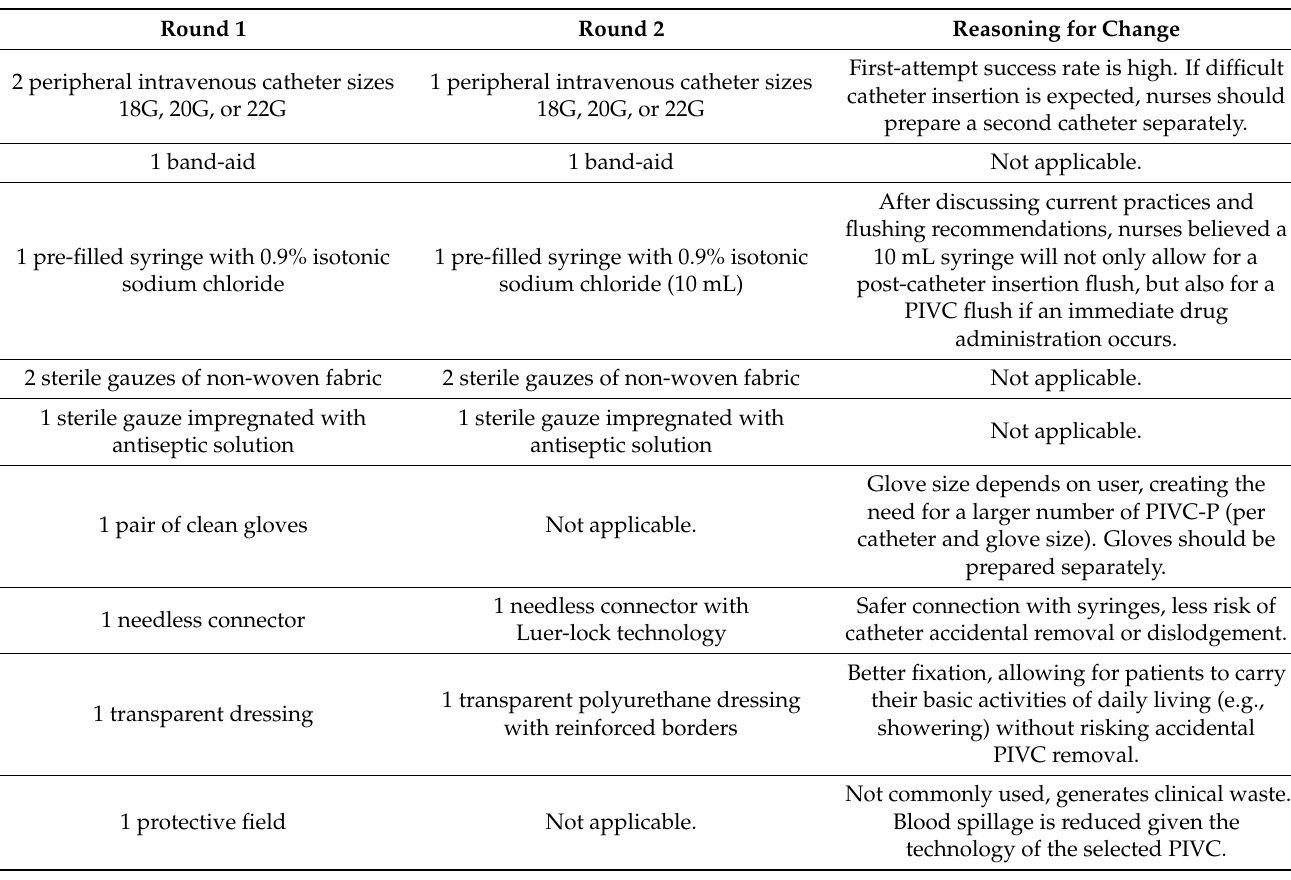
Table 2. Changes to the PIVC-P components between the first and second focus